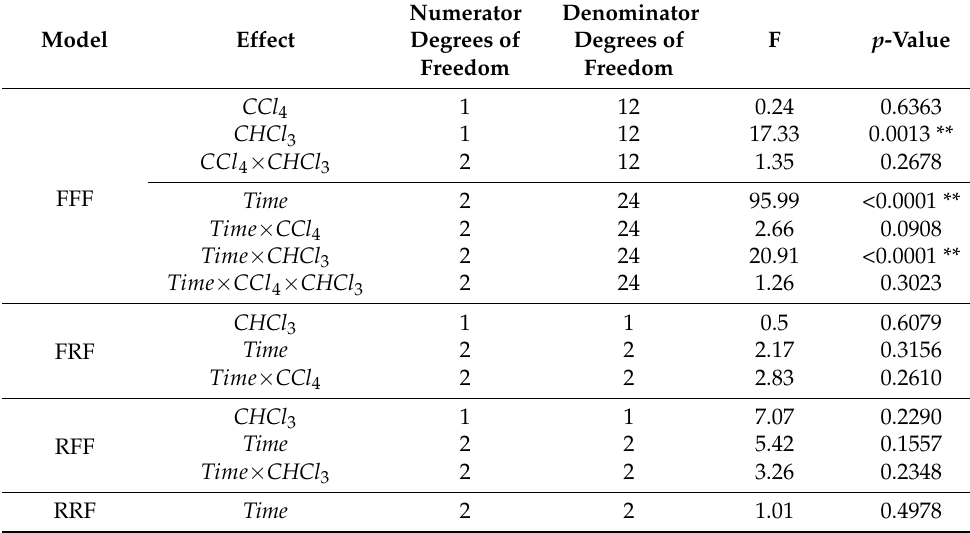
Table 5. Type III tests of fixed effects of FFF, FRF, FFR, and FRR